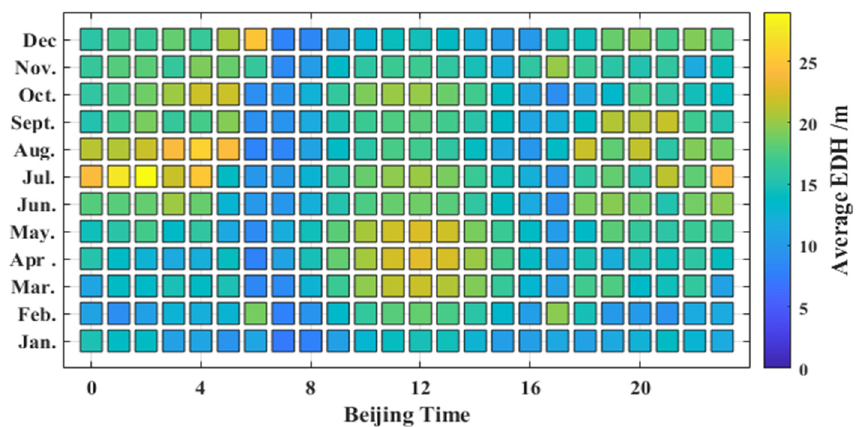
Figure 4. Temporal distribution of the EDH in the Taiwan Strait during 2020.